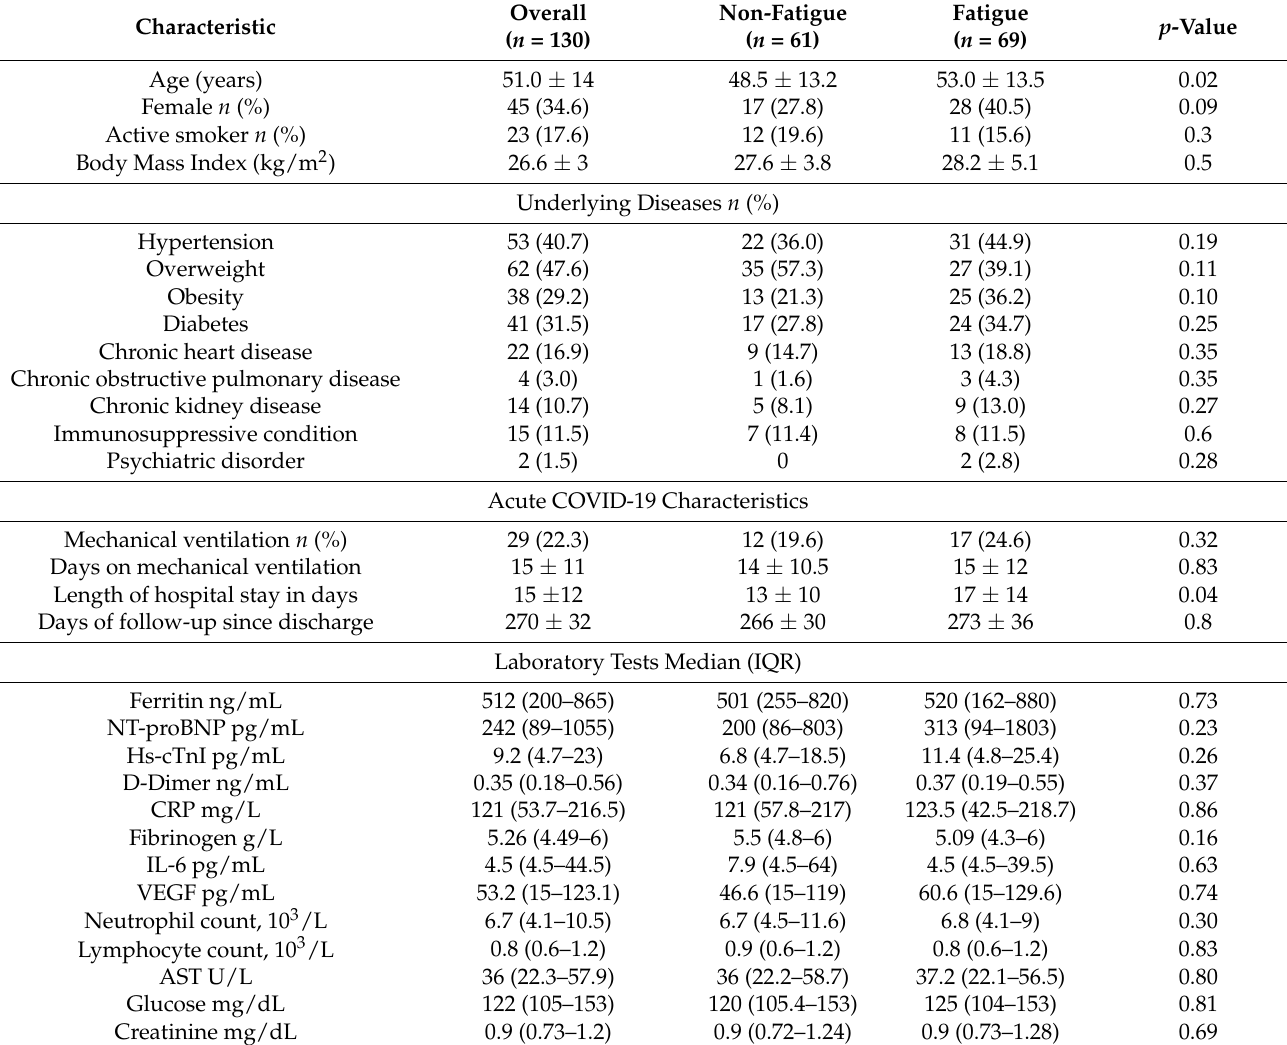
Table 1. Demographic characteristics of study